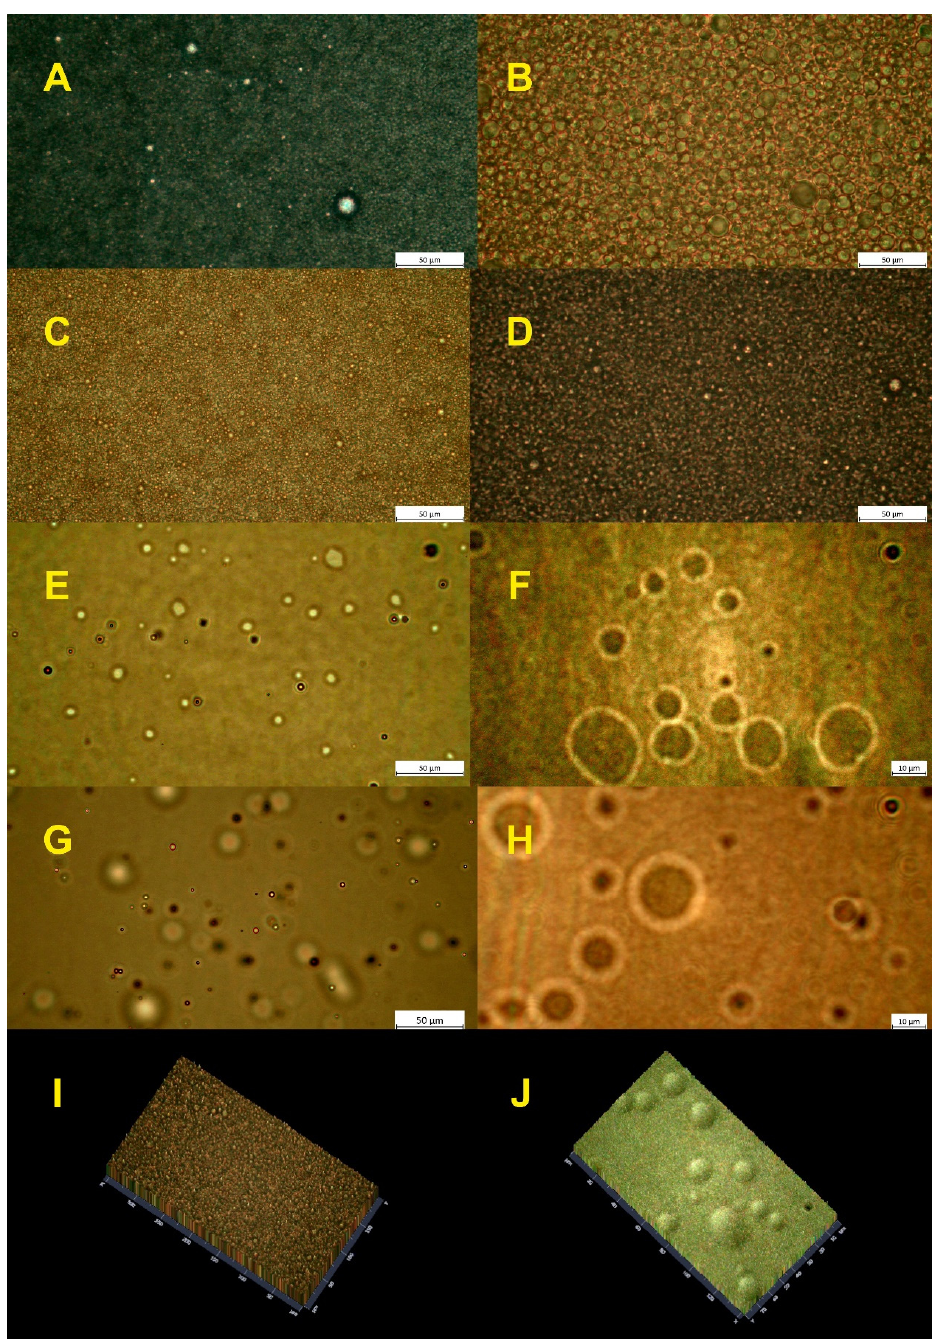
Figure 8. Light microscopy images of 5% HSO in water emulsions: without AHE ( A ) and ( B ) (magnification ×40 and ×100, respectively); with 2 g/L AHE ( C ) and ( D ) (magnification ×40 and ×100 respectively); 5% HSO in Nebudose emulsions: without AHE ( E ) and ( F ) (magnification ×40 and ×100 respectively); with 2 g/L AHE ( G ) and ( H ) (magnification ×40 and ×100 respectively); ( I ) 2.5 D images of the 5% HSO in water emulsion with 2 g/L AHE; ( J ) 2.5 D images of 5% HSO in Nebudose emulsion with 2 g/L.